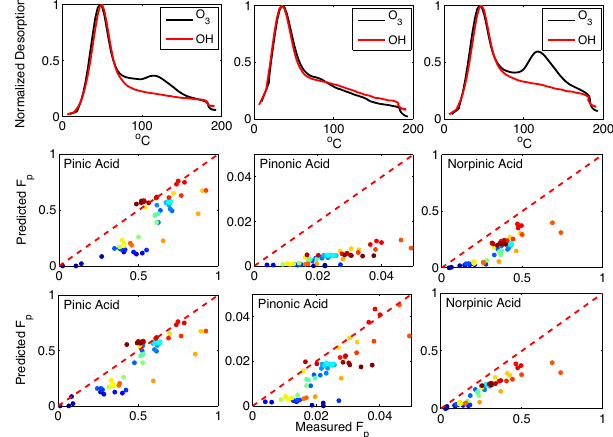
Figure 4. Top panels: thermogram shapes for ozonolysis condi- tions (black) and OH oxidation (red) for the ion compositions corre- sponding to those of pinic, pinonic, and norpinic acids (left to right). Middle panels: comparison between modeled and measured gas- particle partitioning ( F p ). Generally poor agreement is found with nonlinearity and points far from the 1:1 line (red dashed). Bottom: the same partitioning comparison but with the thermogram-fitting routine (Fig. 3) applied to remove the secondary modes in the des- orption profile which are likely a result of thermal decomposition (see text for details). For pinonic acid a single desorption mode is observed under all conditions. To achieve model measurement agreement an activity coefficient of 0.25 is required, or the pure compound vapor pressure used is too high by a factor of ∼